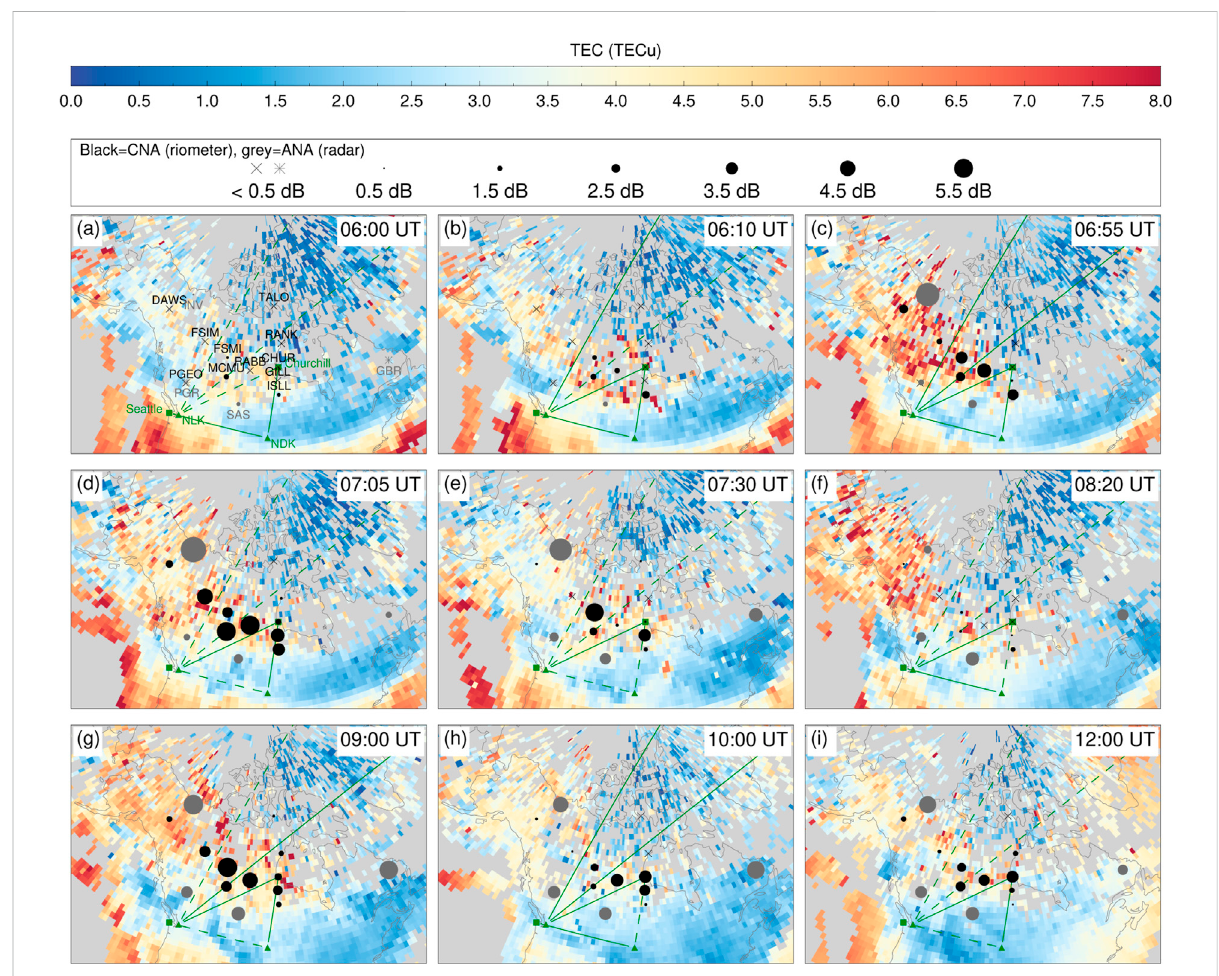
FIGURE 8 Spatial evolution of the vertical total electron content (vTEC), 30 MHz cosmic noise absorption, and 10 – 11 MHz atmosphericnoise attenuation during the substorm on 25 October 2019. The solid green lines show the VLF propagation paths with a signi fi cant amplitude change relative to the referenceperiod,andthedashedgreenlinesindicateVLFpropagationpathswithnosigni fi cantamplitudechange(seetextfordetails).VLF=verylow